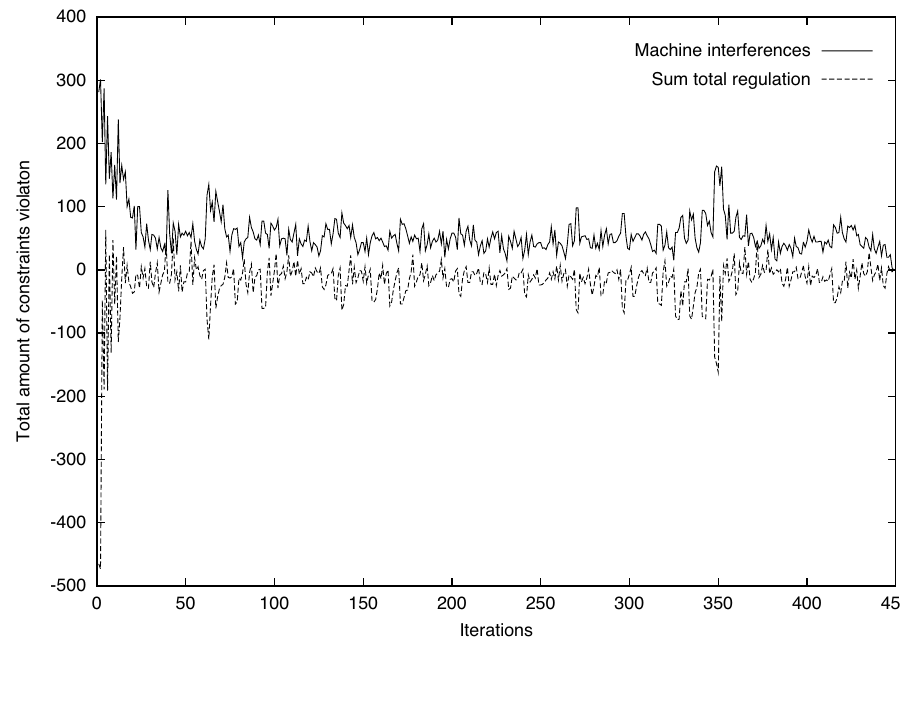
Fig. 2 Transition of the number of time slots at which machine interference occurs and the perturbation value of the total sum